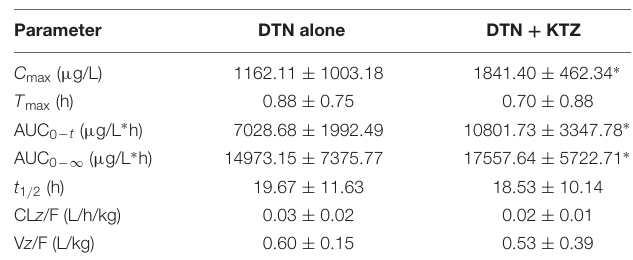
TABLE 2 | Summary of DTN pharmacokinetic parameters obtained in mice with and without pretreatment of KTZ after oral administration of DTN (320 mg/kg for 4 days and 640 mg/kg on the 5th day, n =